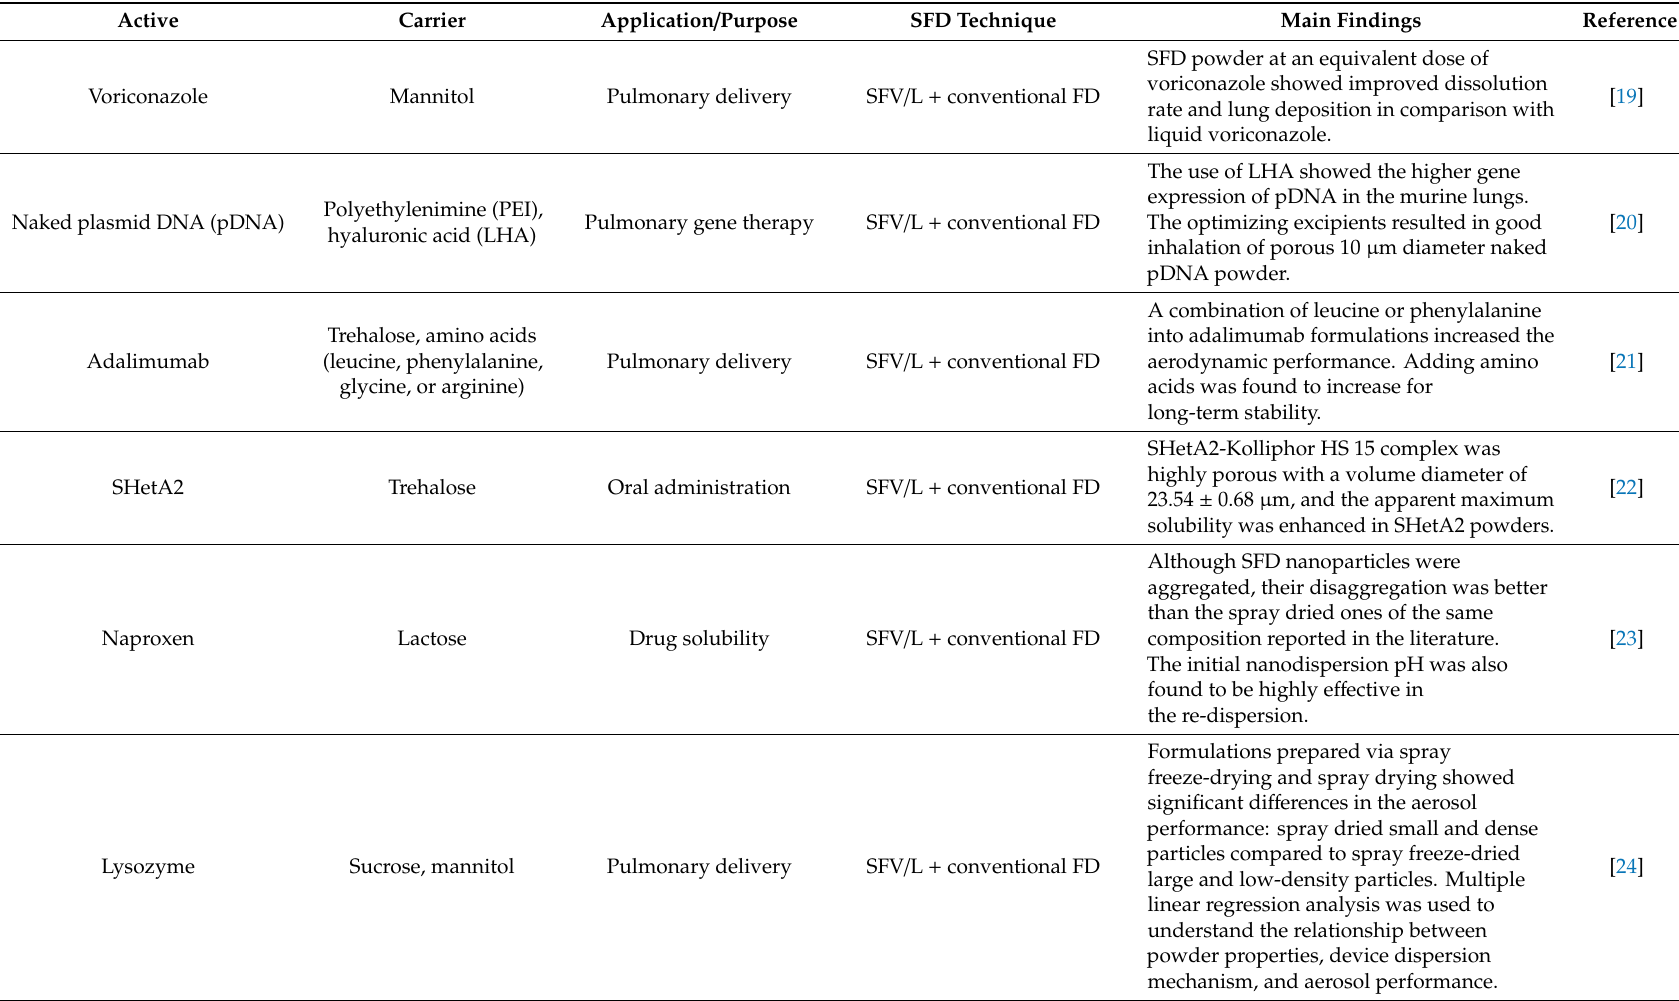
Table 1. Examples of spray freeze-drying techniques reported in the literature for di ff erent purposes: the active ingredient and carrier for each application are